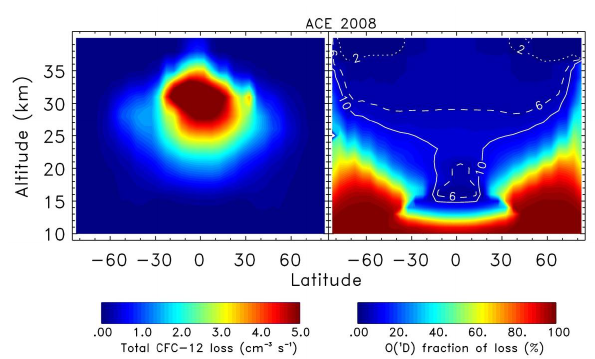
Fig. 5. Loss rate for CFC-12 based on ACE 2008 annual mean data and March distributions of ozone, temperature, and solar conditions (left), along with the fraction of the total loss that results from reaction with O( 1 D) for the same CFC-12 and atmospheric conditions (right). Contours are indicated on the right plot for 2% (dotted), 6% (dashed), and 10% (solid) fraction of O( 1 D) loss.